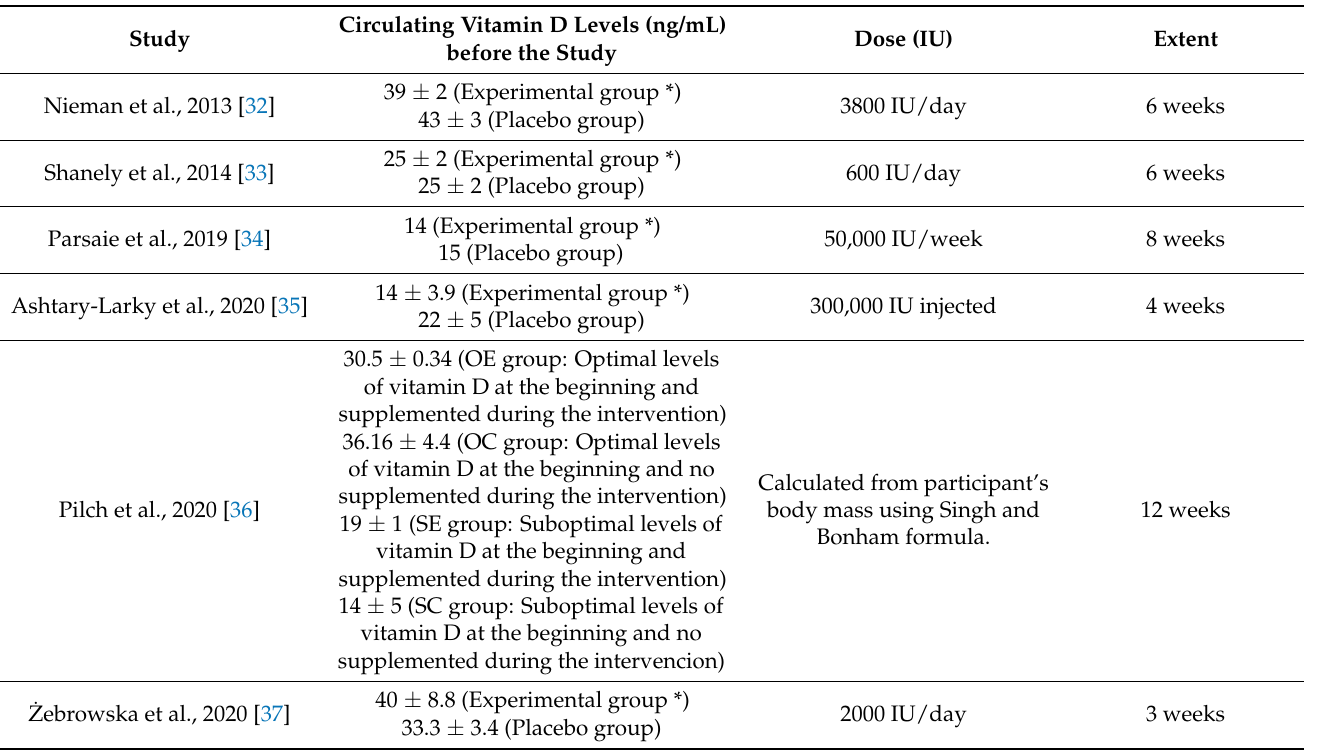
Table 3. Supplementation protocols.